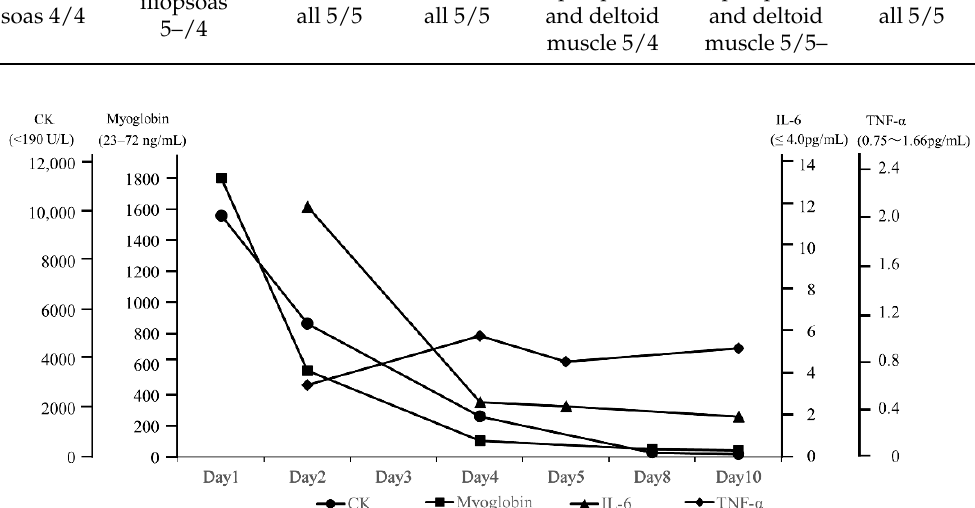
Figure 1. Course of laboratory findings. The patient was admitted and treated with intravenous normal saline for rhabdomyol- ysis and loxoprofen for myalgia. On day 3 of hospitalization, her weakness and myalgia had completely disappeared. However, the next day, follow-up MRI showed slight exacerbation of the hyperintensity of the left upper limb muscles and attenuation of the hyperintensities of the lower limb muscles (Figure 2D–F). Most affected muscles were enhanced, and only the left supraspinatus muscle had homogeneous enhancement (Figure 3A–C). On day 5 of hospitalization, weakness of the left supraspinatus and deltoid muscles (MRC scale 5/4) developed, with swelling and tenderness of the left supraspinatus. A nerve conduction study (NCS) showed that the compound muscle action potentials (CMAP) of the right and left deltoid muscles were 9.210 and 2.540 mV, respectively. MRI on day 8 of hospitalization showed attenuation of the hyperintensity of all muscles. The weakness gradually subsided and then disappeared on day 10 of hospitalization. Electrolytes and renal function were within normal limits during hospitalization. CK, myoglobin, and liver enzyme concentra- tions improved over the course of hospitalization, and the CK concentration returned to normal on day 10 of hospitalization. The patient was discharged the next Figure 2. MRI of the extremities (short-tau inversion recovery images). Imaging on admission showed a high-intensity area in the left dominant bilateral triceps brachii, left supraspinatus,